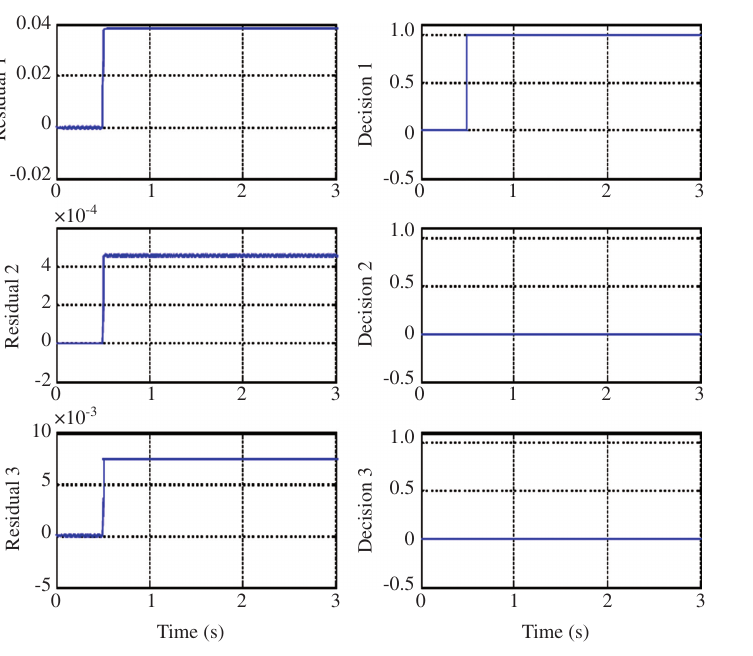
Figure 4. Residuals with a Non-additive Fault on Joint 1 at t = 0.5